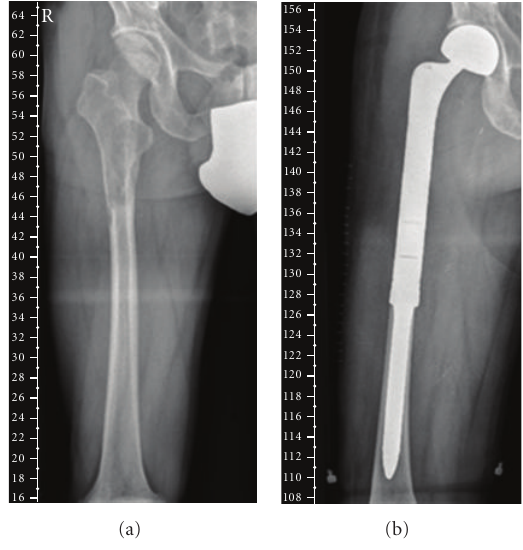
Figure 1: Radiographs of the patient’s right femur: (a) preoperative, an expanding lytic lesion (10cm in max. diameter) located in the right proximal femur with extension into the proximal shaft, (b) two months after limb salvage surgery followed by endoprosthetic replacement.